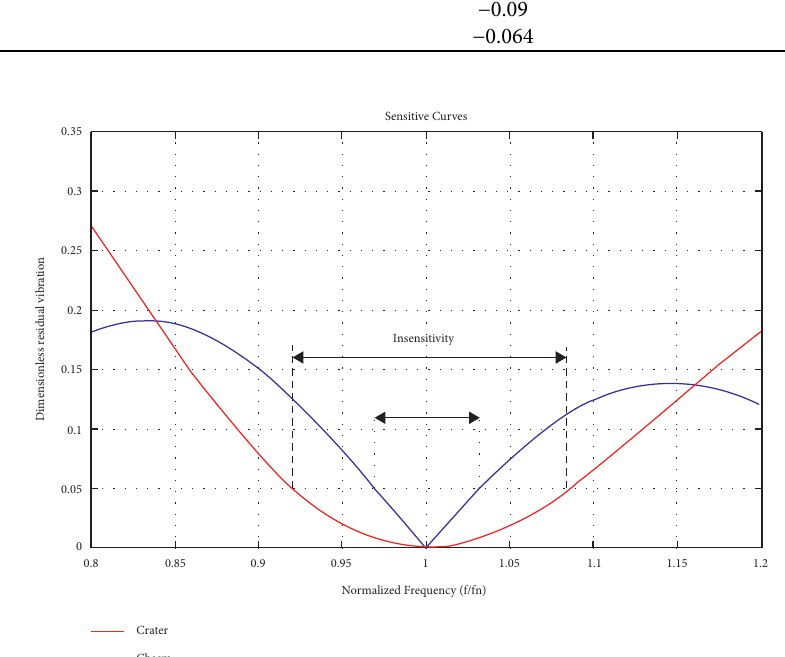
Figure 18: Sensitivity curves of variation in the vibration magnitude against the natural frequency error with f